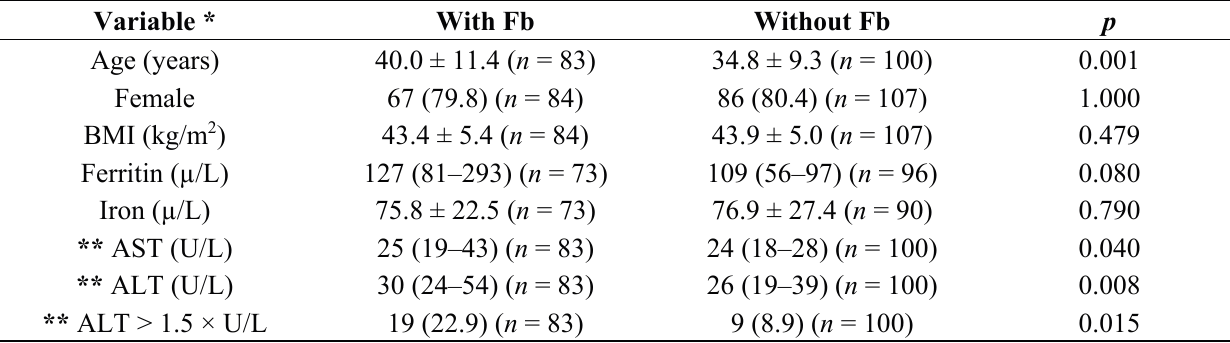
Table 3. Bivariate analysis according to the presence of